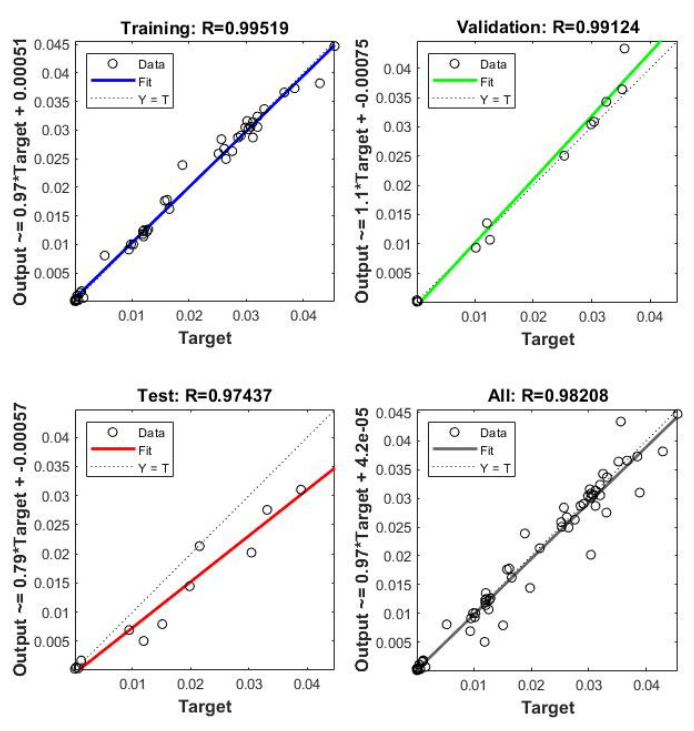
Figure 17. Multi-layer and forward-flow